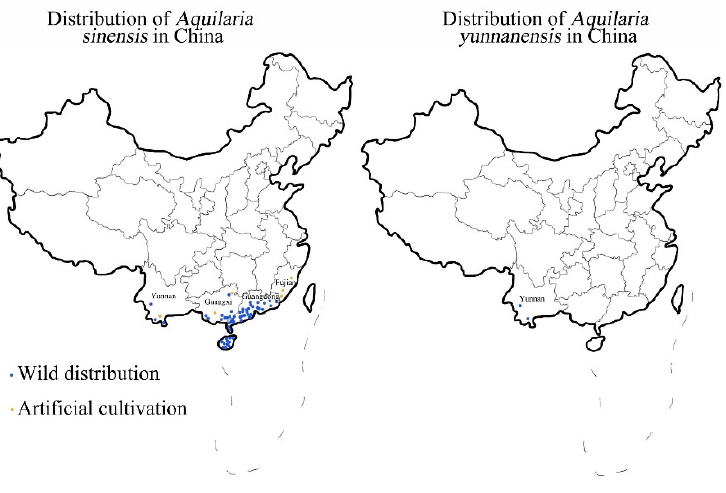
Figure 1. Distribution of A. sinensis and A. yunnanensis in China.